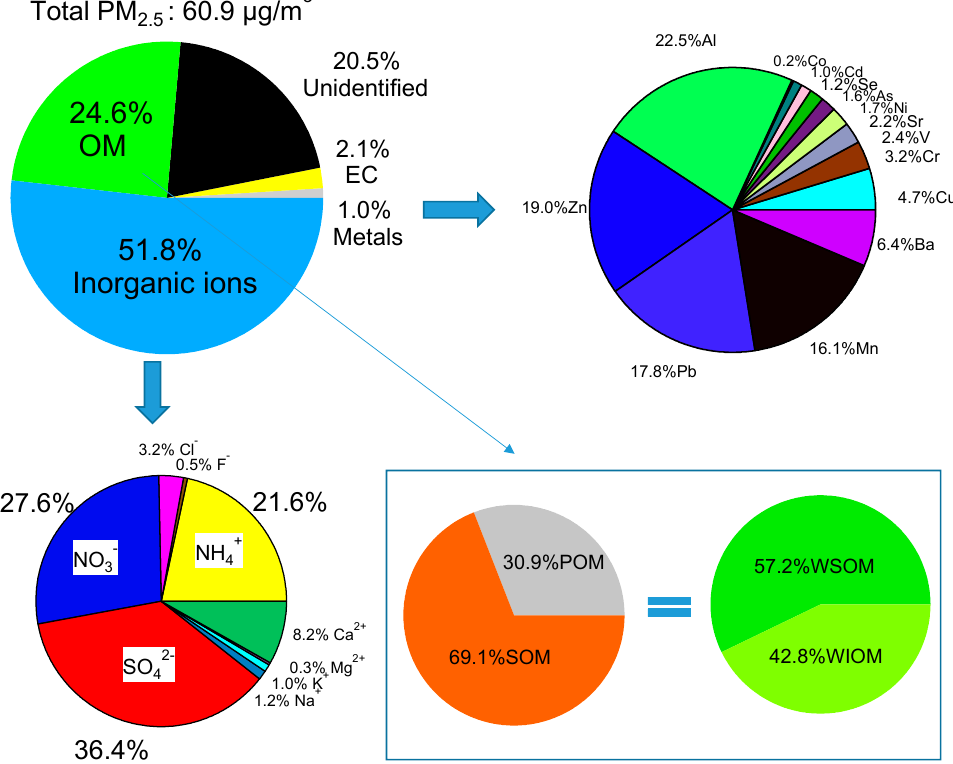
Figure 3. Average chemical compositions of total PM 2.5 , organic matter, ionic species, and trace metals (2016.4.6~2016.11.2).